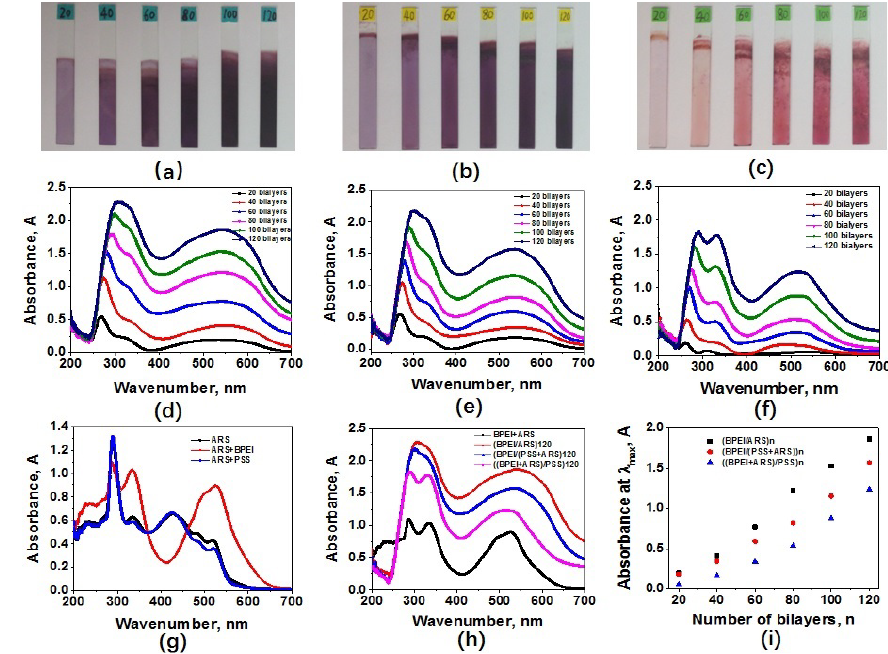
Figure 2. Photographs of ( a ) (BPEI/ARS) n , ( b ) (BPEI/(ARS+PSS)) n and ( c ) ((BPEI+ARS)/PSS) n on ITO-coated glass; UV–Vis spectra of ( d ) (BPEI/ARS) n , ( e ) (BPEI/(ARS+PSS)) n and ( f ) ((BPEI+ARS)/PSS) n on ITO-coated glass; ( g ) UV–Vis spectra of ARS, ARS+BPEI and ARS+PSS; ( h ) UV–Vis spectra of BPEI+ARS solution, (BPEI/ARS) 120 , (BPEI/(ARS+PSS)) 120 and ((BPEI+ARS)/PSS) 120 on ITO-coated glass; ( i ) Relationship of the number of bilayers or layers pairs and the absorbance of the films at the maximum absorption